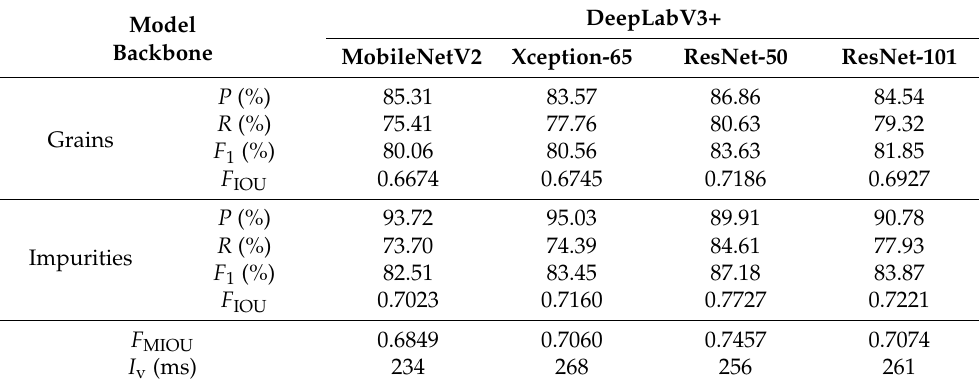
Table 1. DeepLabV3+ model recognition and segmentation performance of different